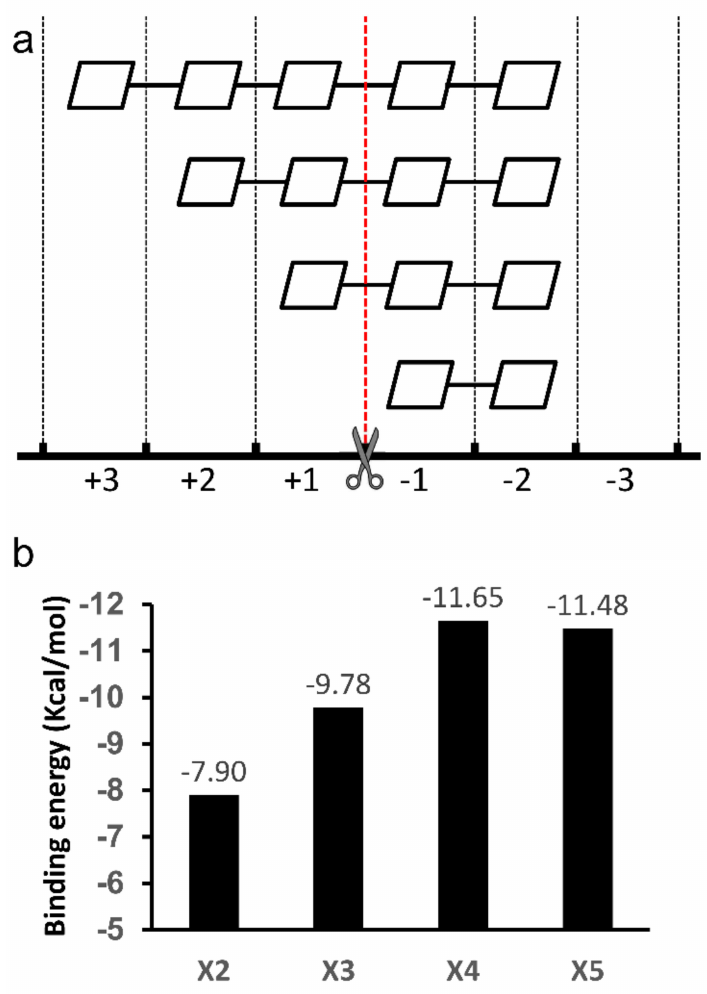
Figure 8. Summary of the binding modes of xylooligosaccharide (XOS) in TmxB. ( a ) Proposed positional binding of XOS to the active-site cleft in TmxB on the basis of the docking structures. The cleavage position is indicated by a scissor. ( b ) The binding energy changes with the backbone length of